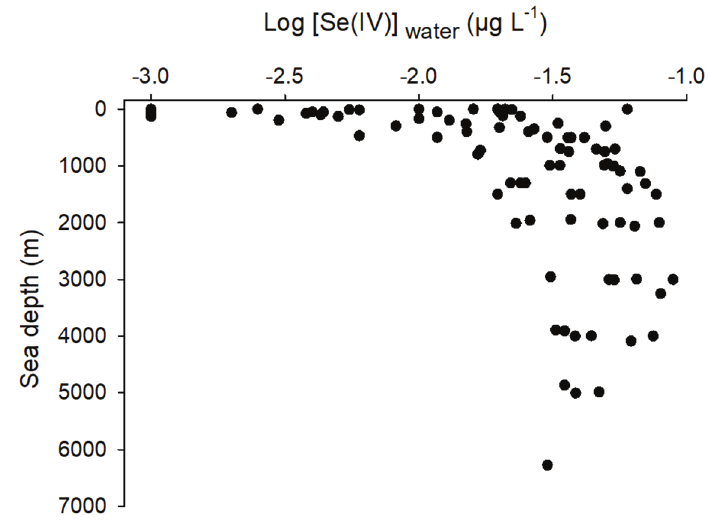
Figure 5. Log-transformed selenite concentrations (Log [Se(IV)] water , µ g L − 1 ) as a function of oceans depth (m) from several oceanic cruises (modified from Conde and Sanz Alaejos [21]).